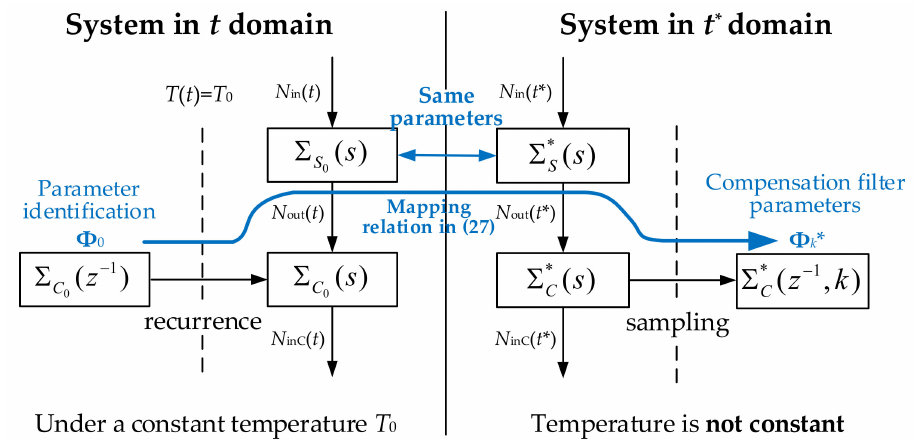
Figure 7. The relationship between several systems after substitution and